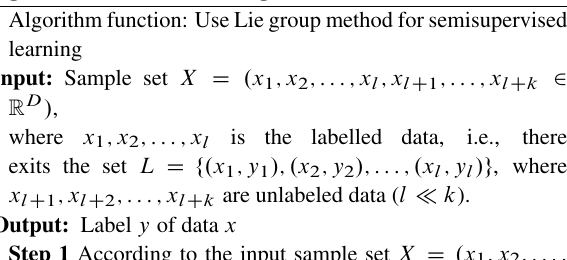
Algorithm 9 SSLA-PLG algorithm flow Algorithm function: Use Lie group method for semisupervised